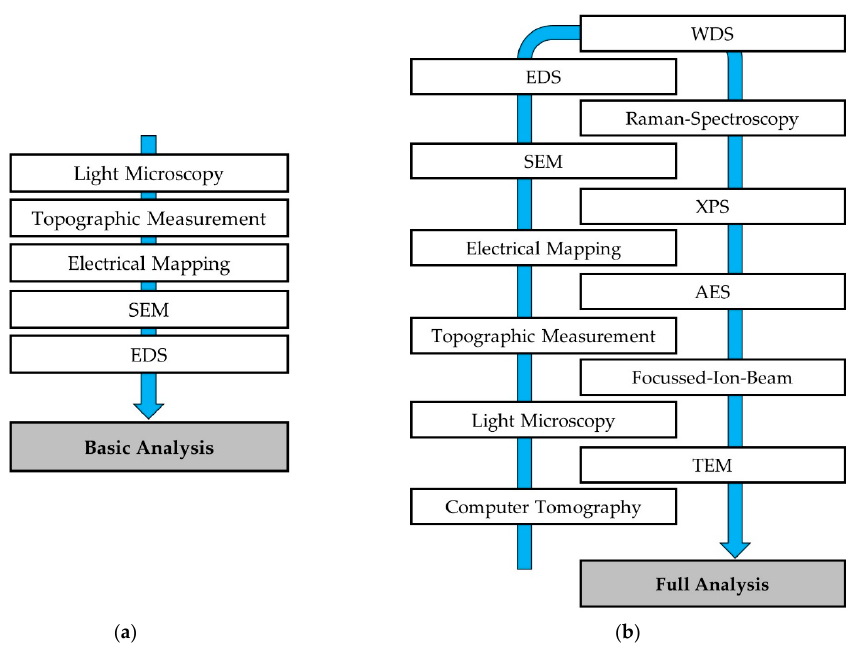
Figure 13. Recommendations for analyses workflows for the investigation and evaluation of failure modes of electrical connectors: ( a ) Basic analysis; ( b ) Comprehensive